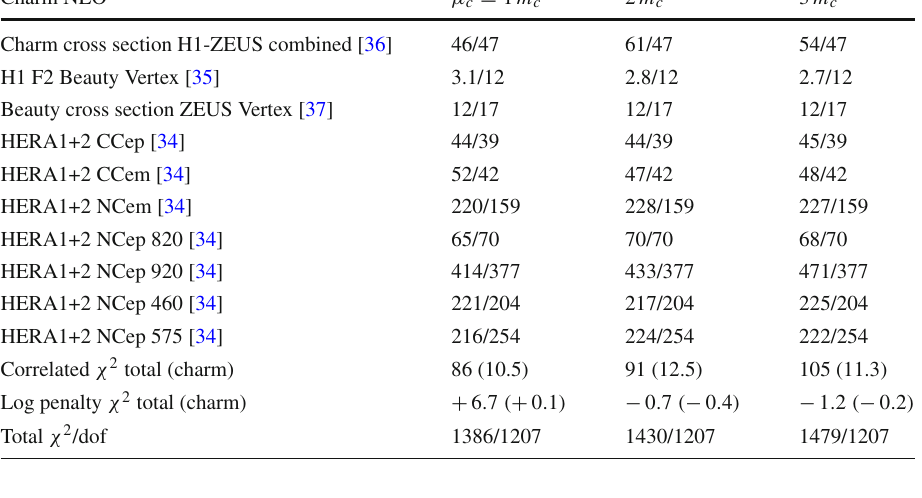
NNLO for individual data sets for a selection of the charm matching scales μ c . The contribution of the charm